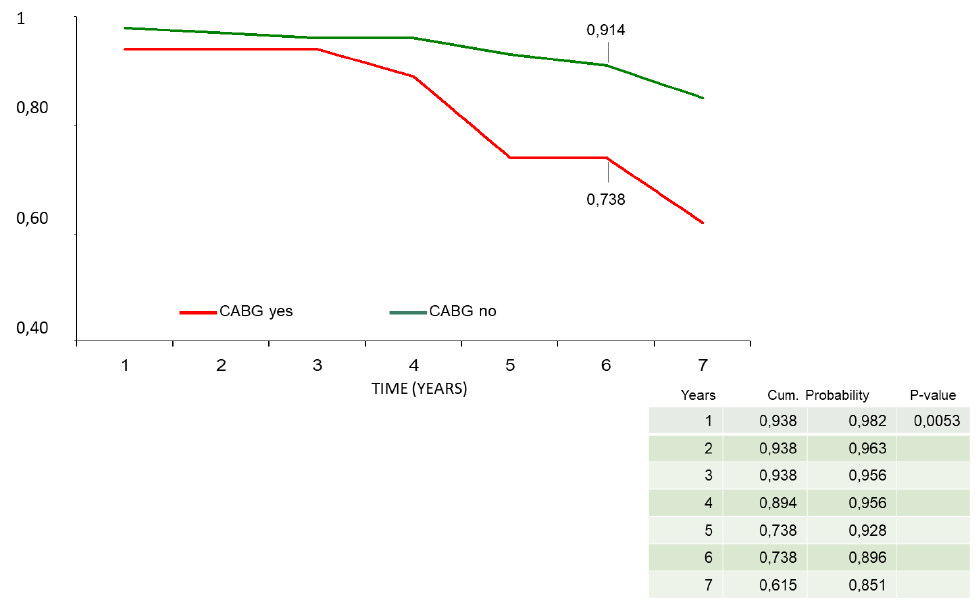
Figure 6. Adverse-event-free survival stratified by concomitant CABG (Mantel–Cox test). CABG: coronary artery bypass grafting.